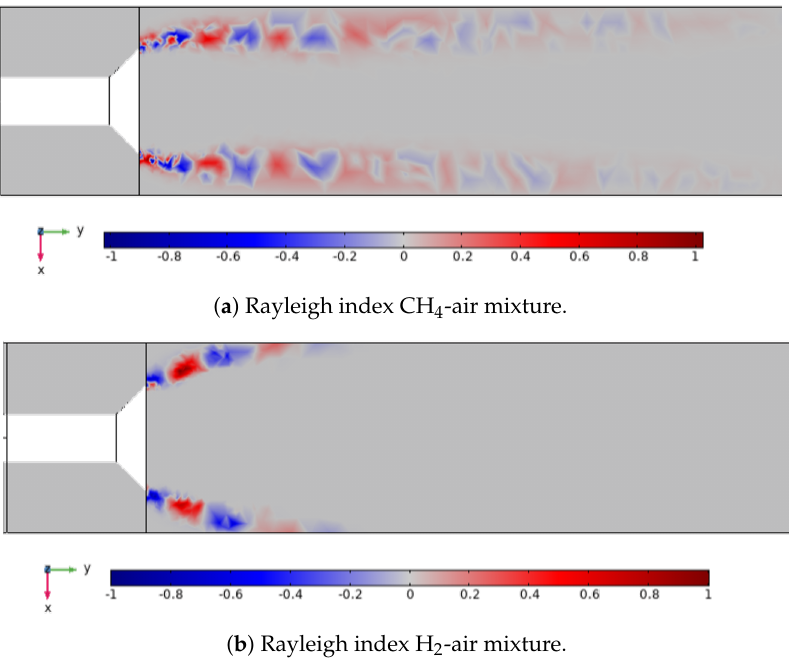
Figure 23. Comparison of the Rayleigh index for the methane–air ( a ) and hydrogen–air ( b ) mixtures.